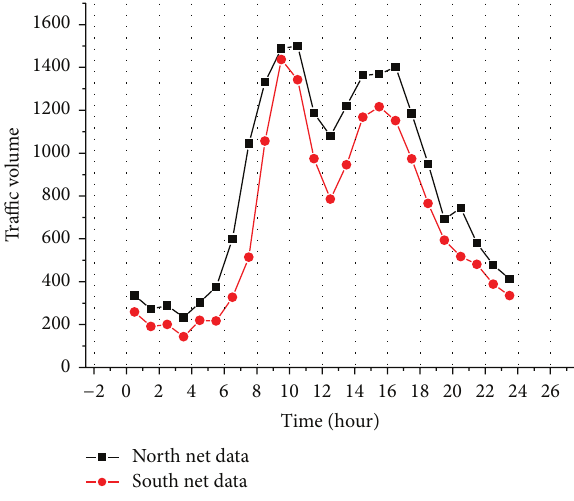
Figure 8: Traffic flow in every hour during a